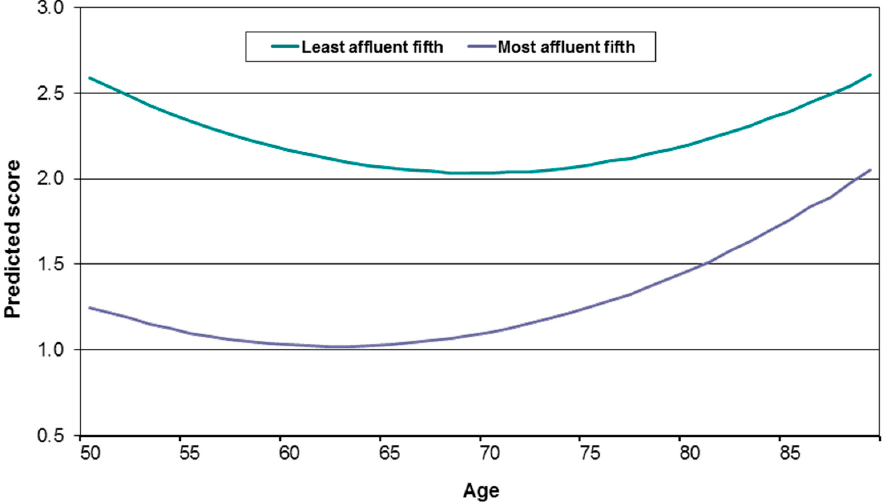
Figure 3. Age and level of depressive symptomatology, stratified by wealth.